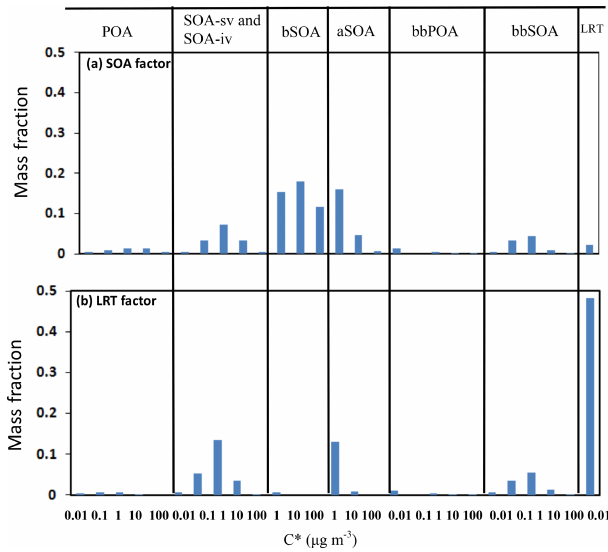
Figure 1. Factor profiles resulting from the PMF analysis of the PMCAMx-SR OA predictions in Melpitz: (a) SOA factor and (b) LRT factor.